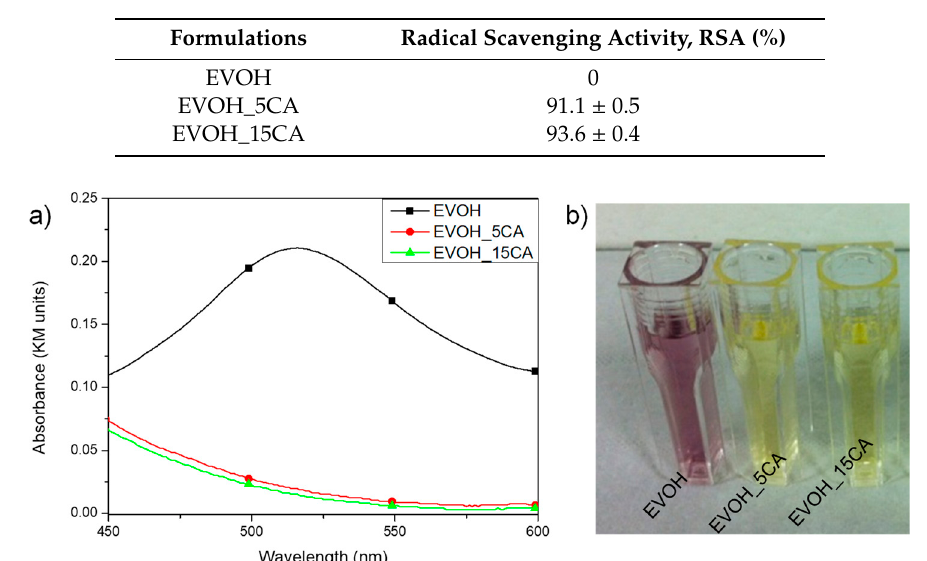
Table 4 . Radical scavenging activity (RSA) of EVOH based systems. Table 4. Radical scavenging activity (RSA) of EVOH based systems.